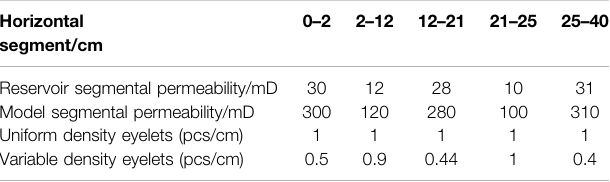
TABLE 3 | Table of H1 well segmentation and physical model parameter